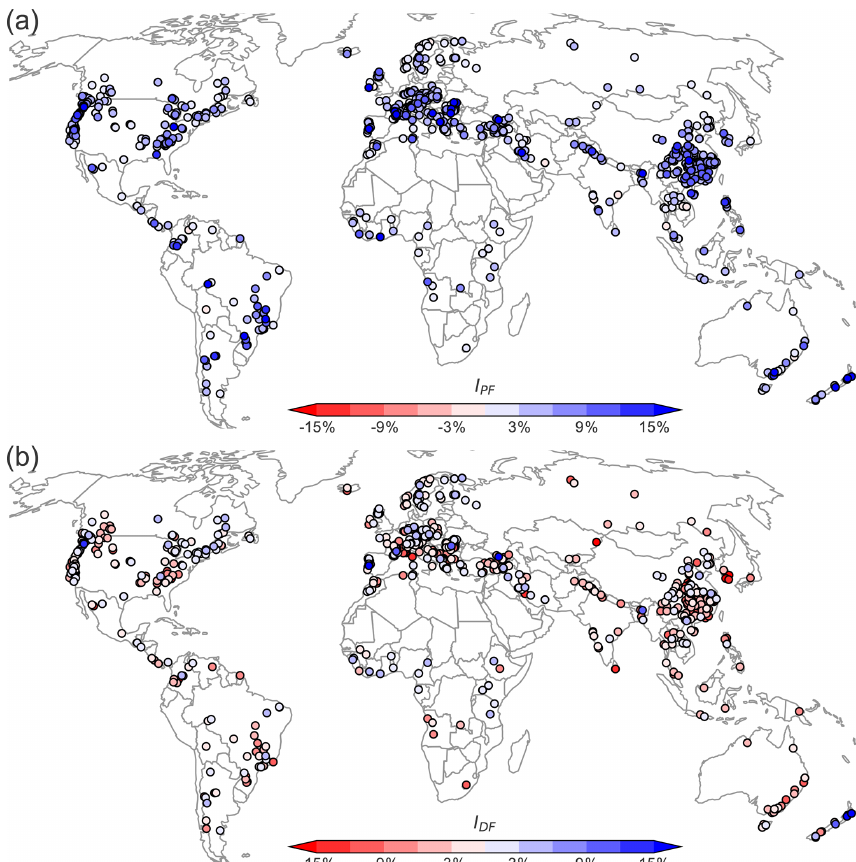
Figure 4. Improvements in hydropower production using perfect (a) and realistic (b) forecasts. The terms I PF and I DF indicate the relative improvement in hydropower production (with respect to the basic control rules) provided by perfect and realistic forecasts. Nearly all dams are able to benefit from perfect forecasts, but only 25% of dams benefits from realistic forecasts.